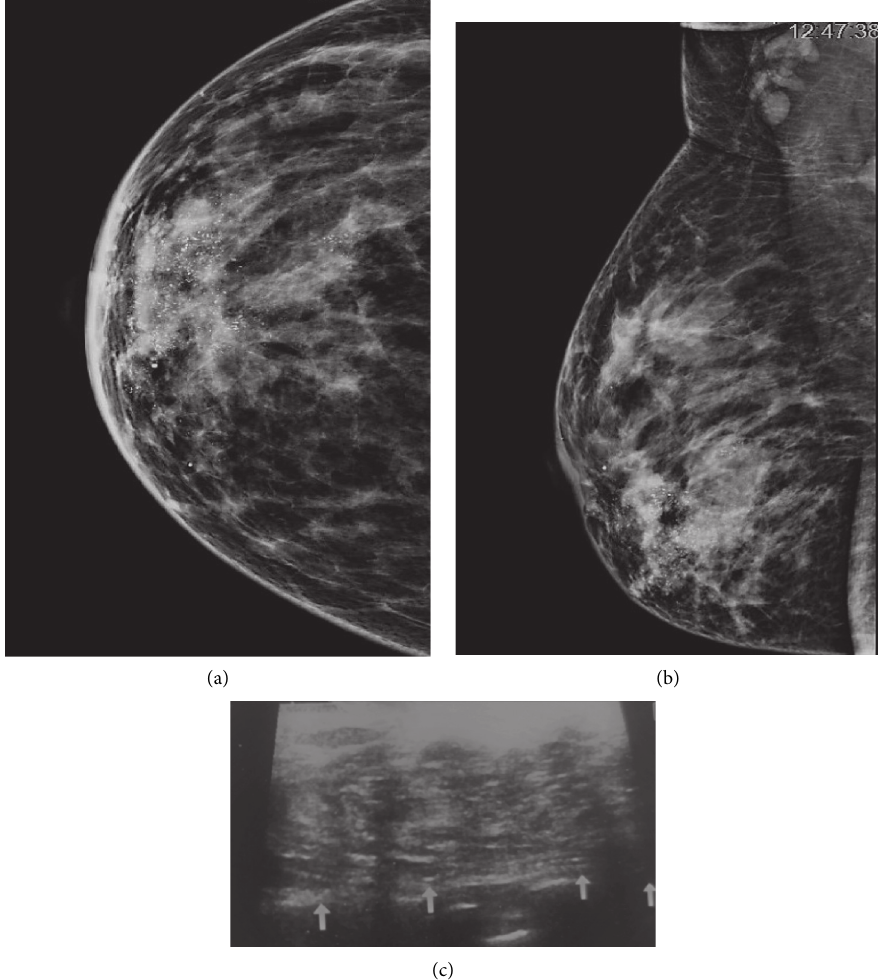
Figure 3: CC and MLO views of right breast. (a) Biopsy-proven infiltrating ductal carcinoma Her-2 enrich tumor (grade I). There is a high- density mass in retroareolar region extending to the lower quadrant. Irregular spiculated margins are seen along with visualization of extensive microcalcification within the mass. (b) Overlying skin thickening is also seen. Suspicious axillary lymph nodes are also there. (c) Ultrasound of the same patient shows a complex mass with partly ill-defined and partly irregular anterior margins. Abrupt boundary is seen with parallel orientation of this mass with the chest wall (wider than taller). No posterior features. Sono-mammometry score: